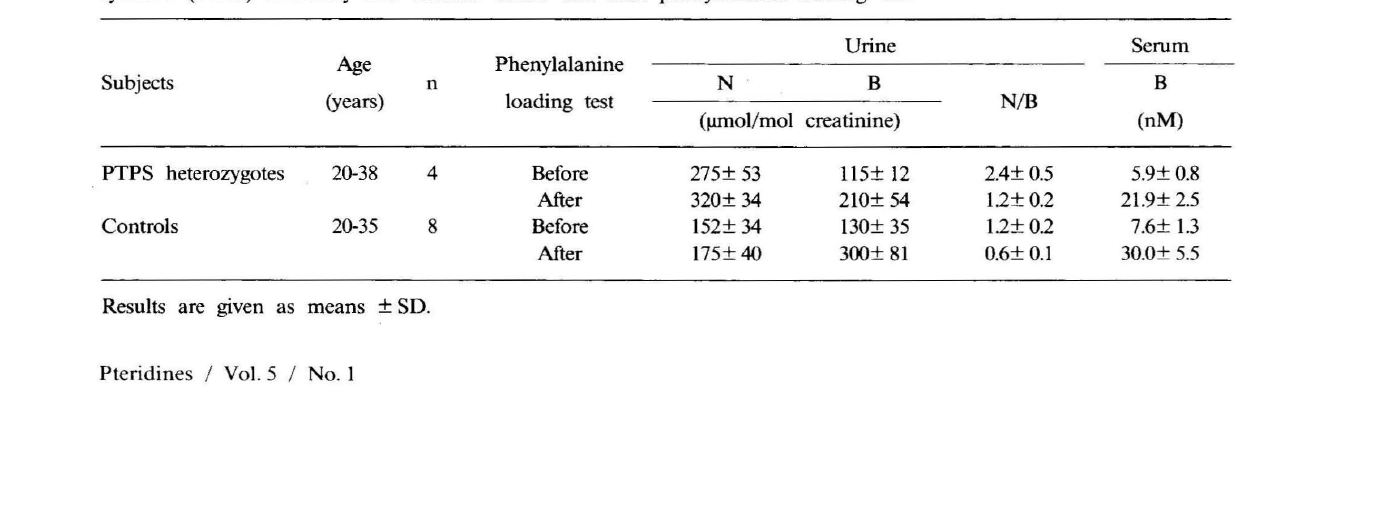
Table 4. Urinary neopterin (N), biopterin (B), and NIB and serum B levels in heterozygotes for 6-pyruvoyl-tetrahydropterin synthase (PTPS) deficiency and controls before and after phenylalanine loading test